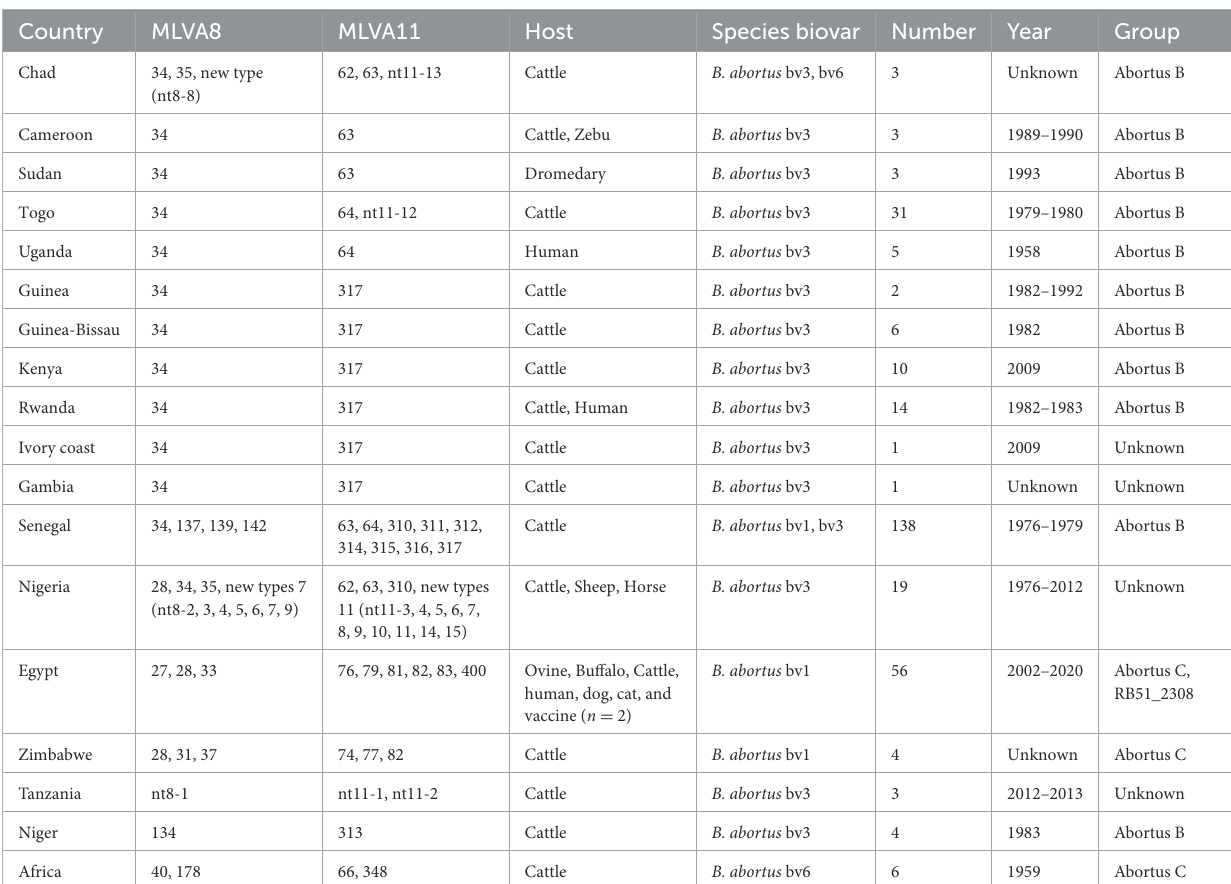
TABLE 2 Country, MLVA-8, MLVA-11, host, species/biovar, number, and year of 309 B. abortus strains used for MLVA genotyping.